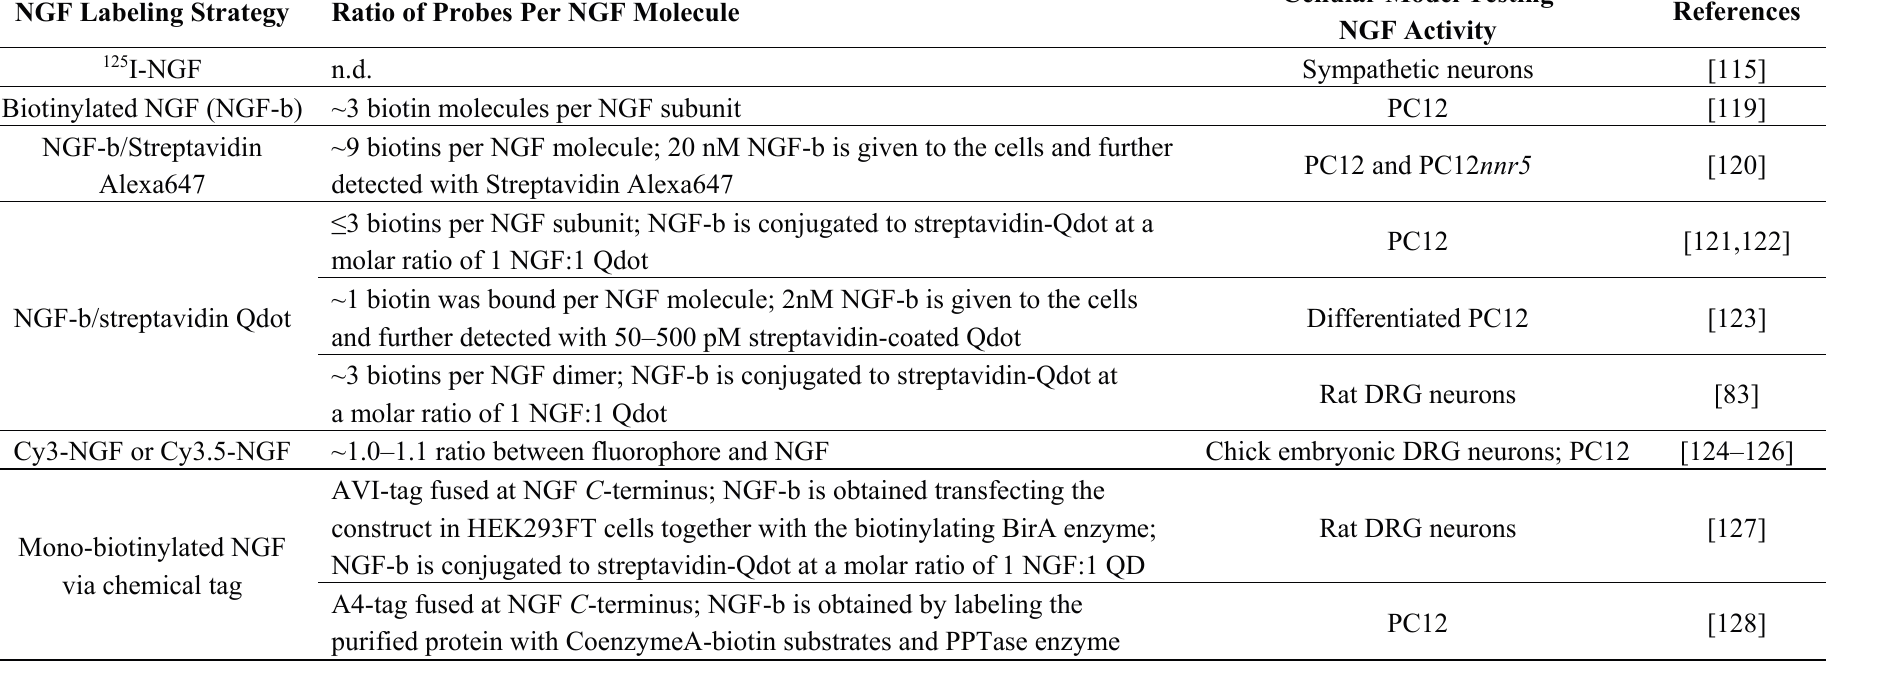
Table 2. List of the main labeled NGF (nerve growth factor) derivatives reported in